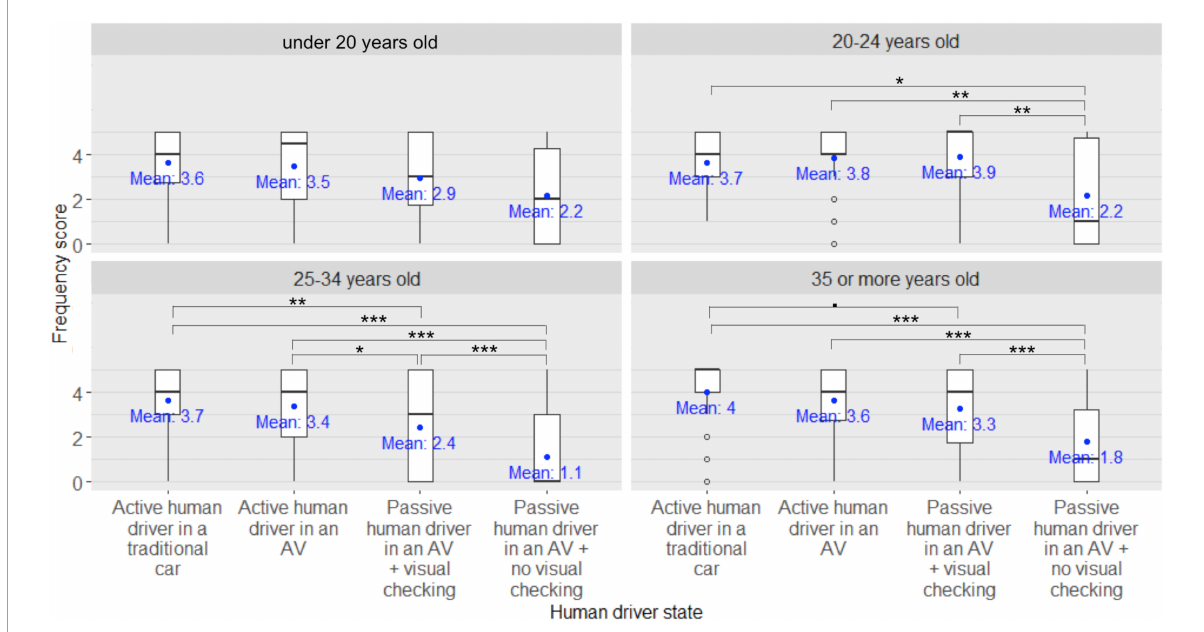
FIGURE10 External Human-Machine Interface (eHMI) type × participants’ age group interaction on the kick scooter users’ frequency score for ensuring that the human driver has made eye contact in order to take their effective crossing decision • : pFDR < 0.10, *: pFDR < 0.05, **: pFDR < 0.01.